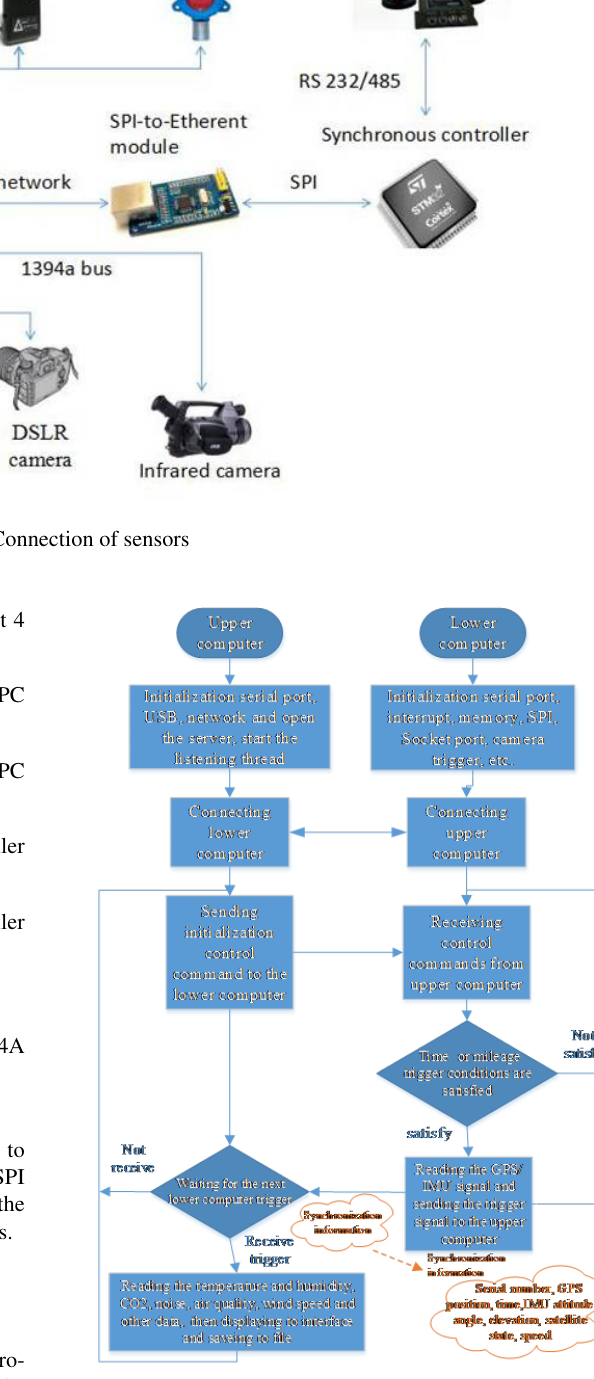
Figure 3. The connection of the upper computer and lower